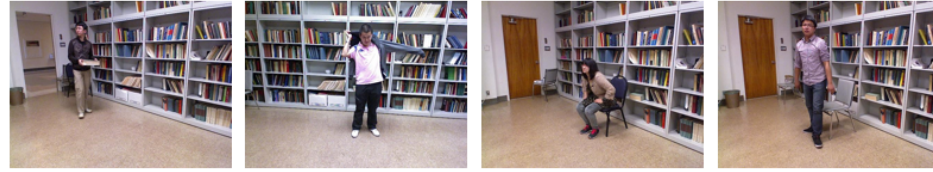
Figure 7. Samples of the NUCLA dataset.